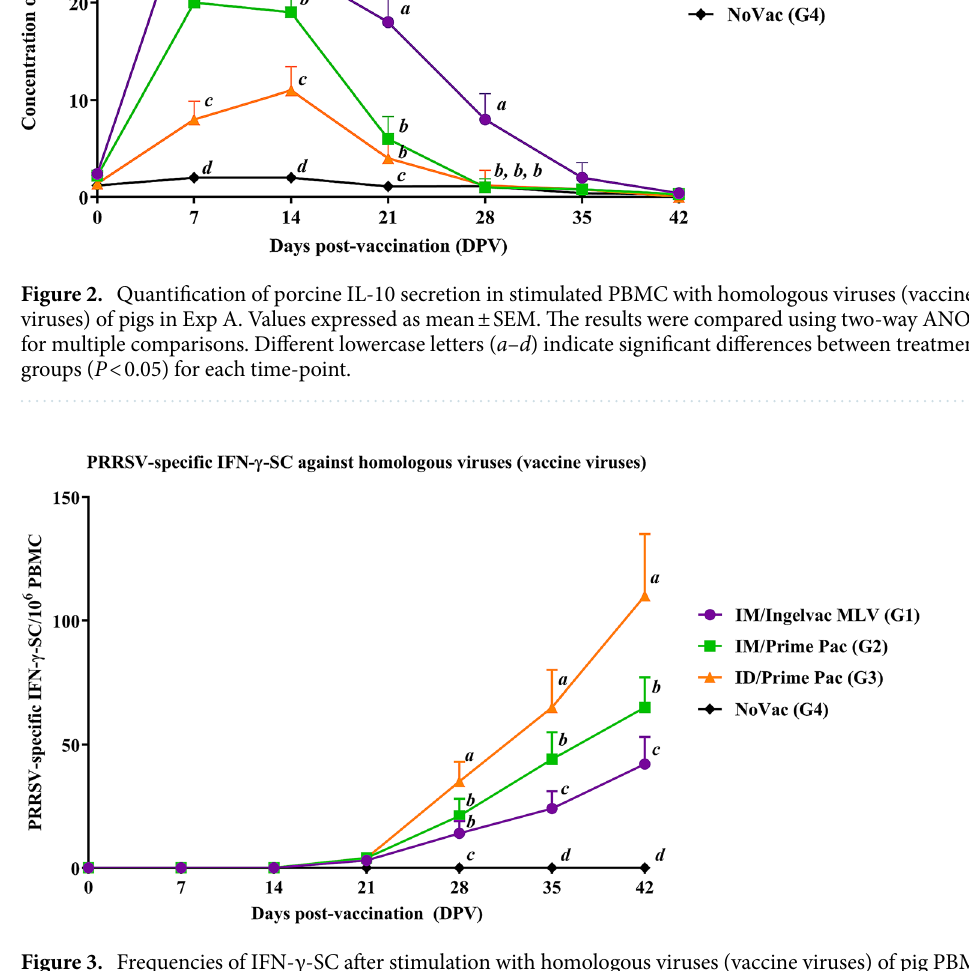
Figure 3. Frequencies of IFN-γ-SC after stimulation with homologous viruses (vaccine viruses) of pig PBMC in Exp A. Values expressed as mean ± SEM. The results were compared using two-way ANOVA for multiple comparisons. Different lowercase letters ( a – d ) indicate significant differences between treatment groups ( P < 0.05) for each